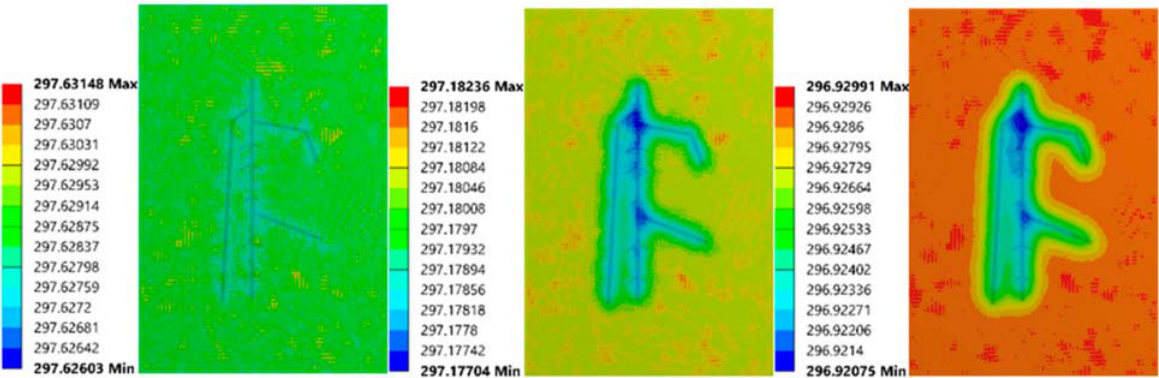
Figure 3. Upper surface’ thermal images of 2 mm root depth model at 17 s ( left ), 27 s ( mid ), and 40 s ( right ).